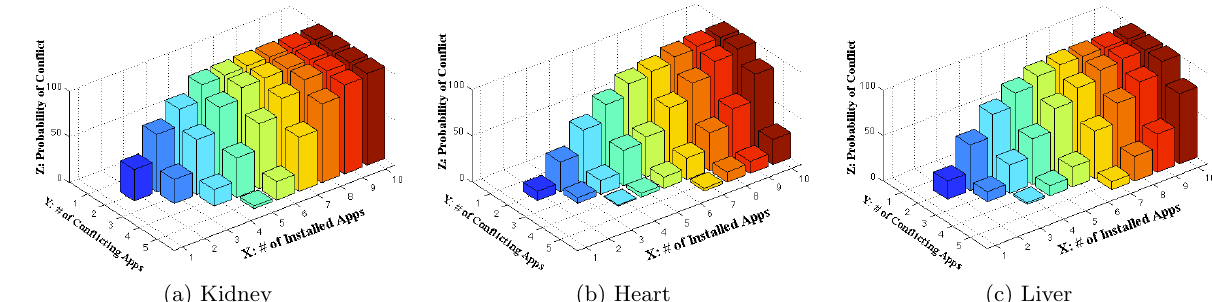
Figure 5: Installation time conflict detection on low level parameters related to the (a) Kidney, (b) Heart, and (c) Liver in addition to the high level parameters.